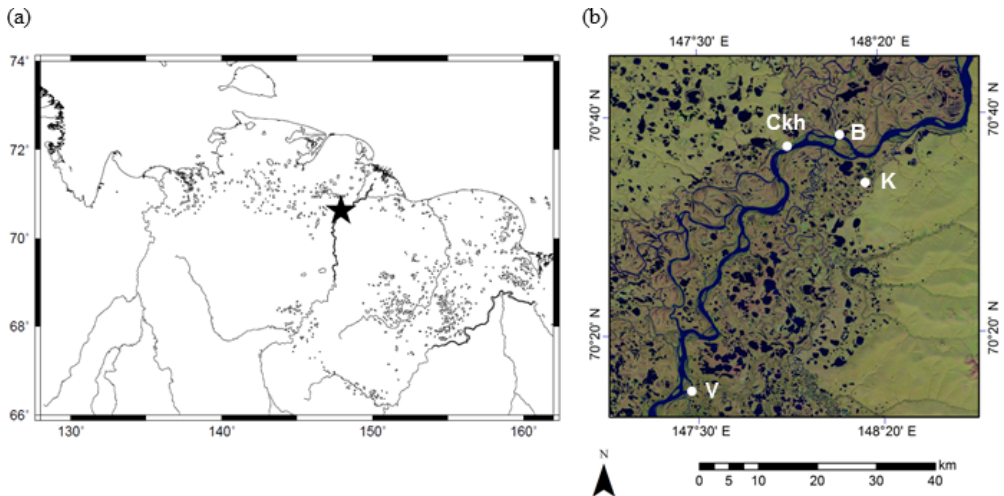
Figure 1. Locations of study sites. (a) Location of study region in northeastern Siberia (the Generic Mapping Tools 5.0.0). (b) Satellite image of Indigirka River lowland around Chokurdakh village (Ckh: 70 ◦ 37 (cid:48) N, 147 ◦ 55 (cid:48) E) from Landsat 8. Observation sites (V, K, B) were selected in this region beside the main stem and a tributary of the Indigirka